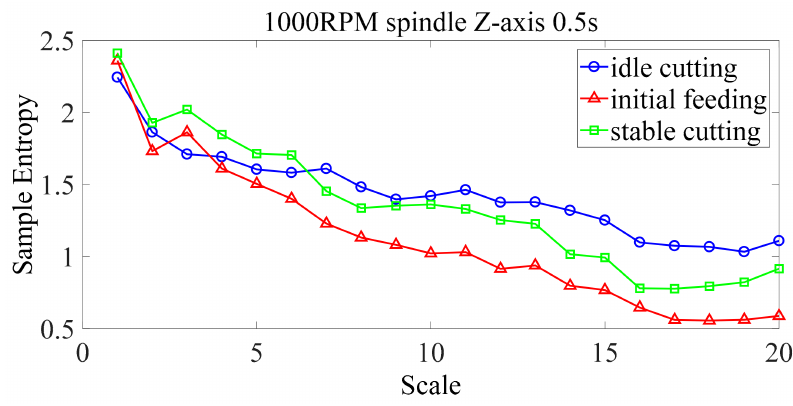
Figure 7. MSE distribution of vibration signal at Z axis at 1000 rpm.